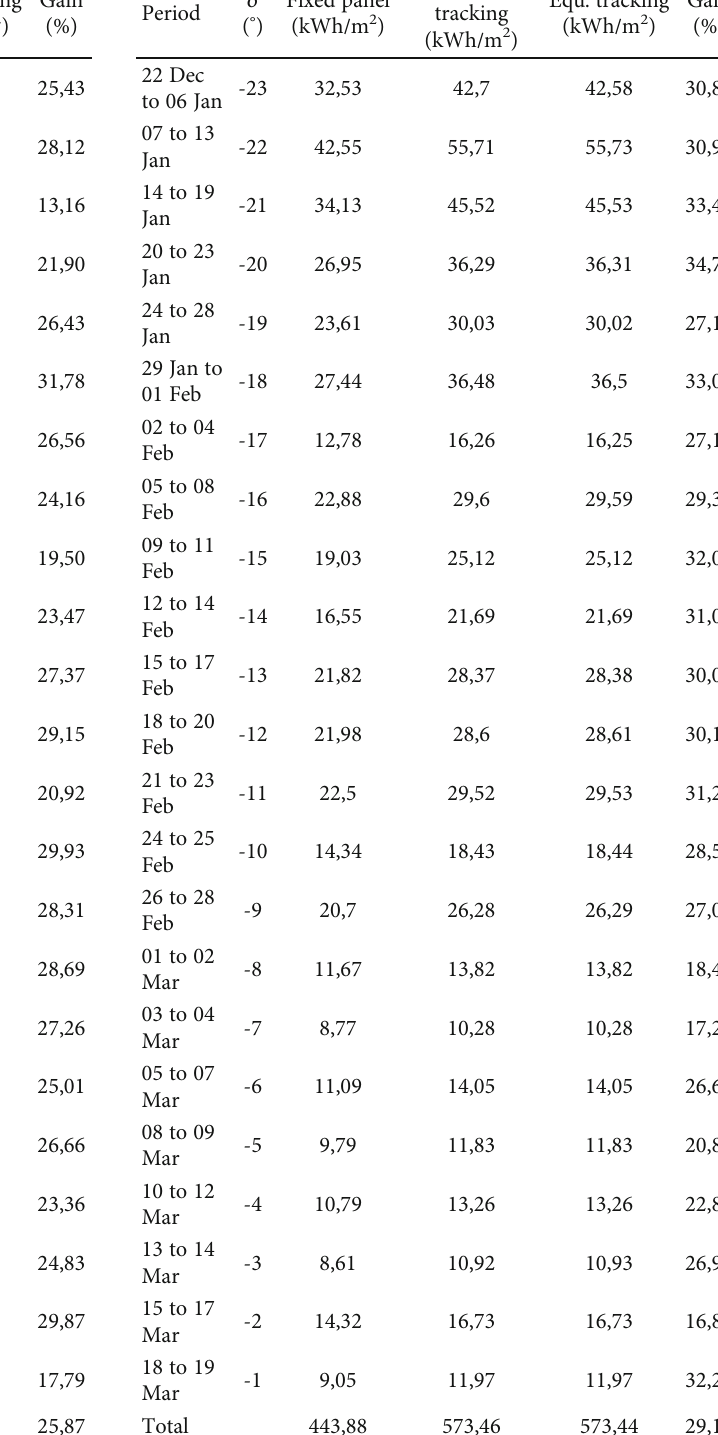
Table 3: The results of the autumn simulation. Table 4: The results of the winter